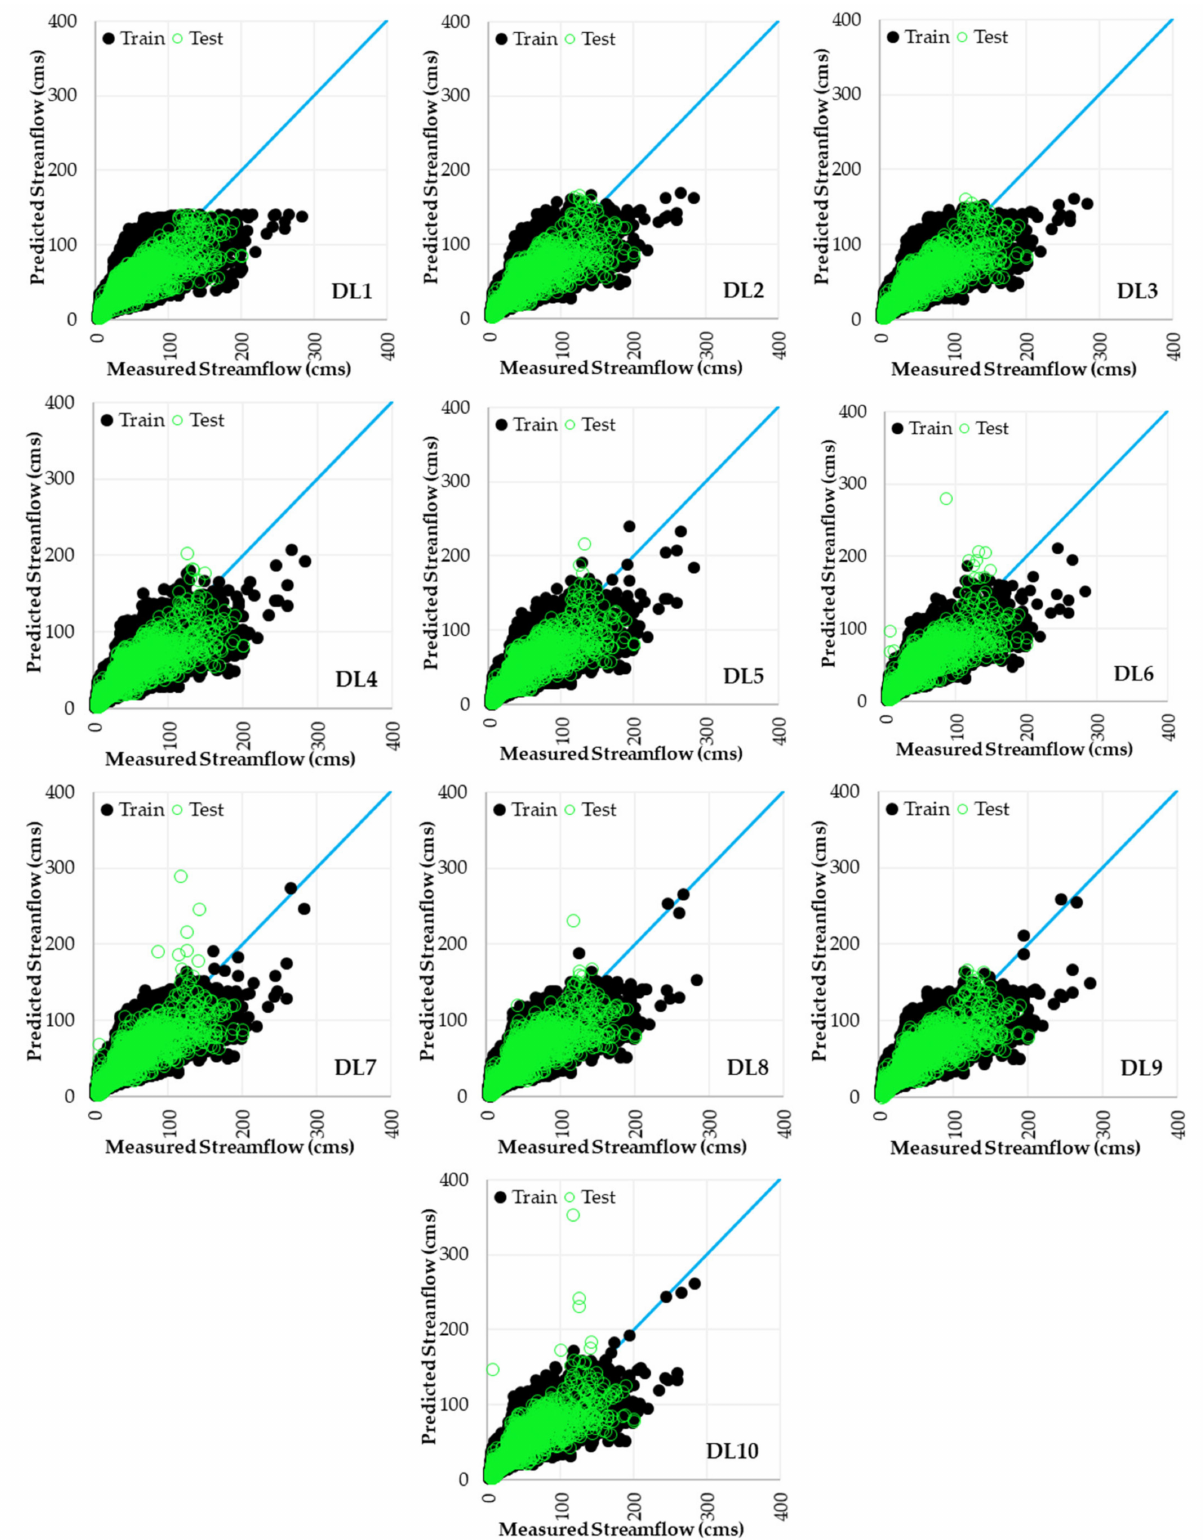
Figure 7. Scatter plots of observed vs. modeled streamflow by DL1 to DL10